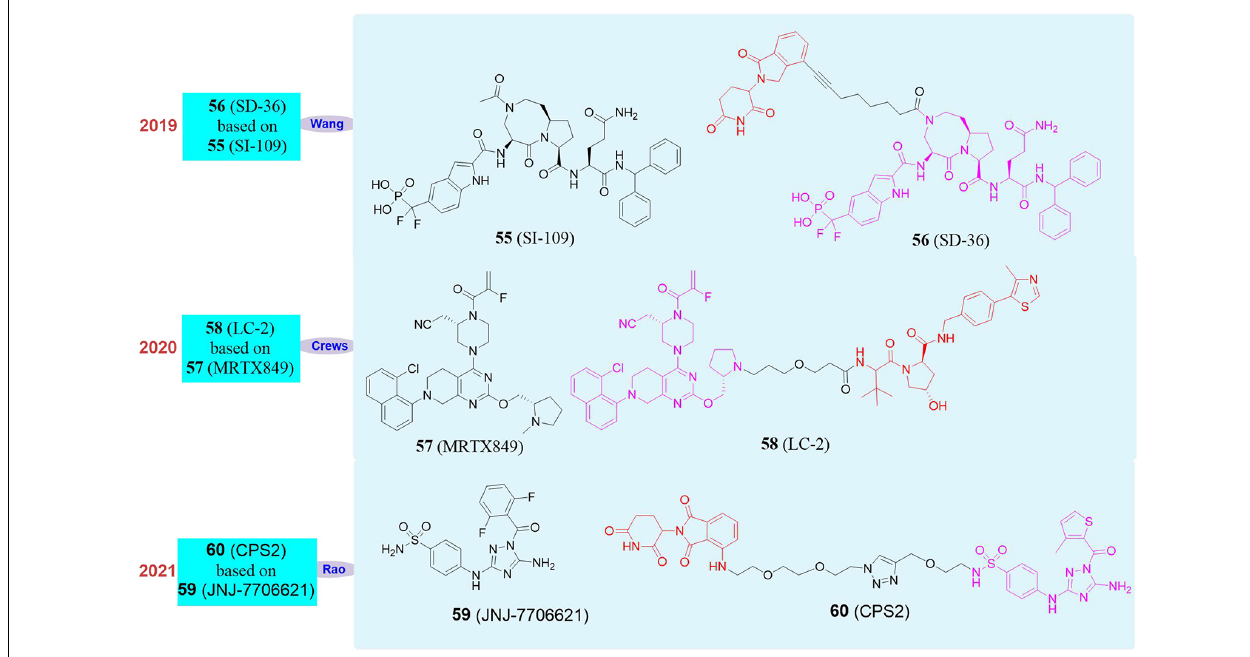
FIGURE 10 | Structures of STAT3, KRAS G12C and CDK2 inhibitors and degraders.